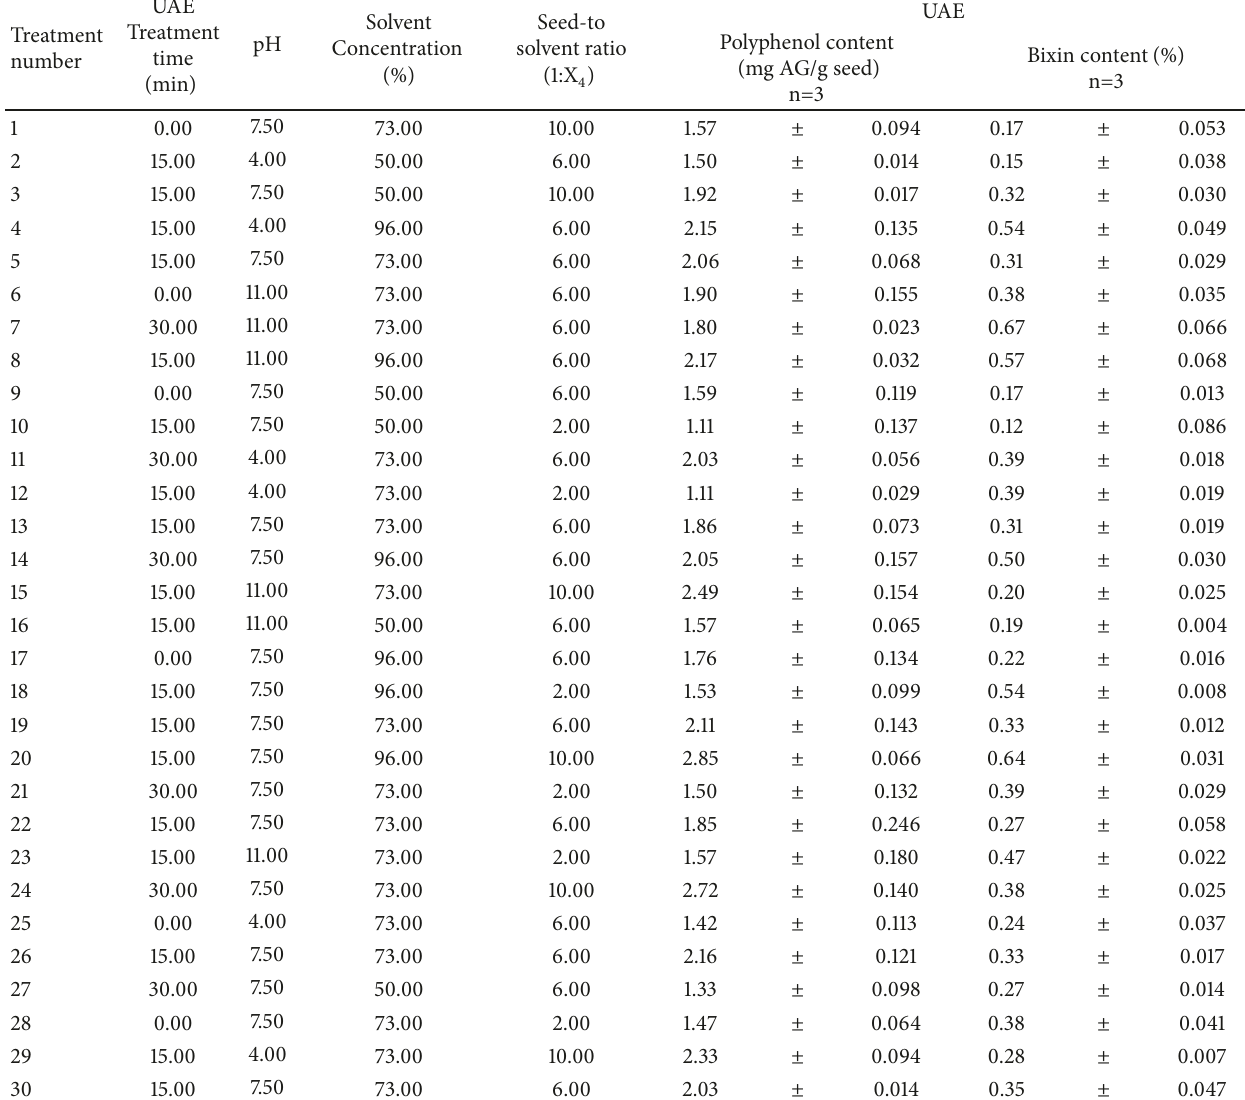
Table 1: The experimental matrix for the UAE of bioactive compounds from annatto seeds.